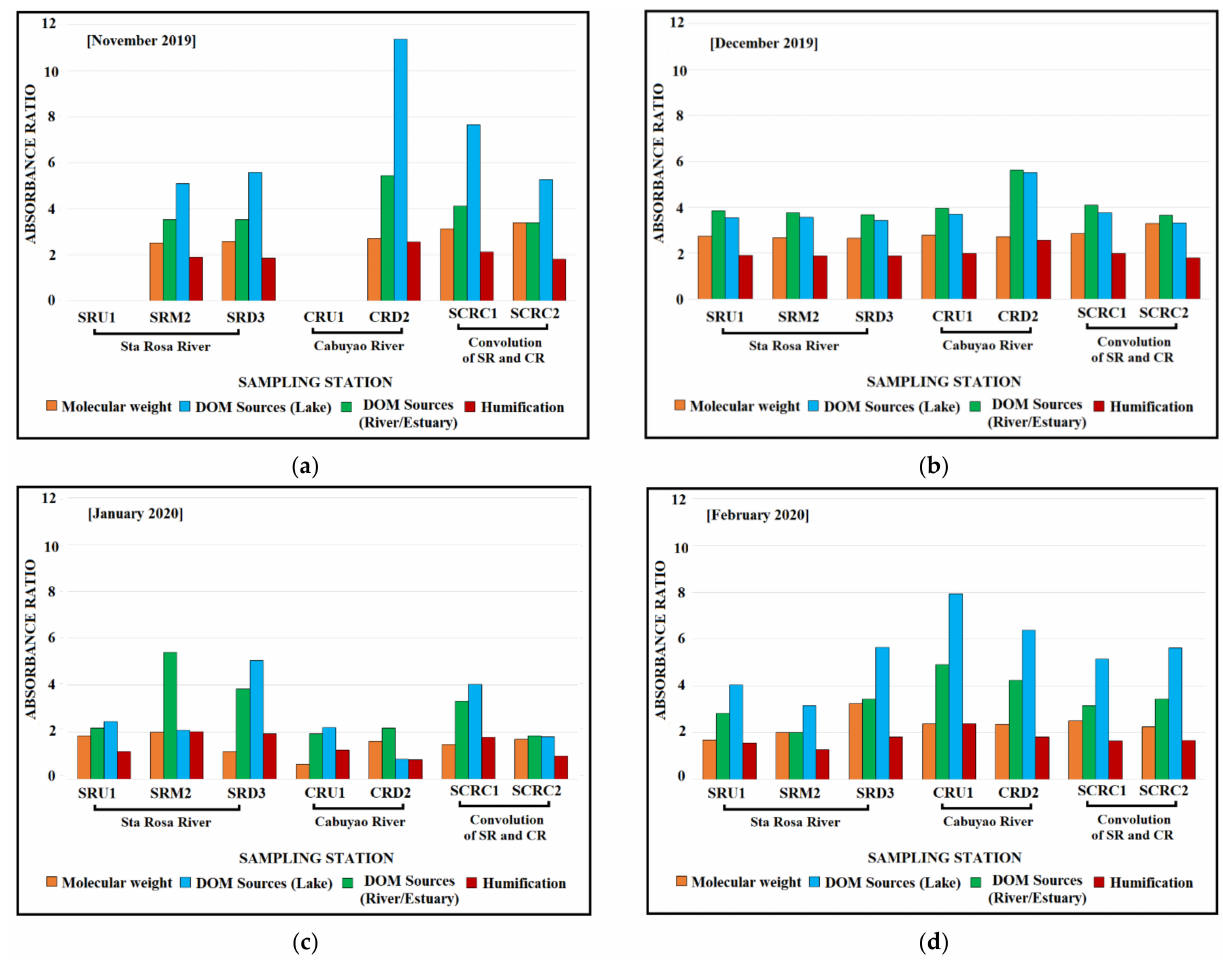
Figure 2. Distribution of absorbance ratio in SR and CR. The absorbance ratios used for the analysis are as follows: (1) Molecular weight at A250/363, (2) DOM sources at A254/436, (3) DOM sources at A250/665, and (4) Humification at A300/400. These measurements were conducted for